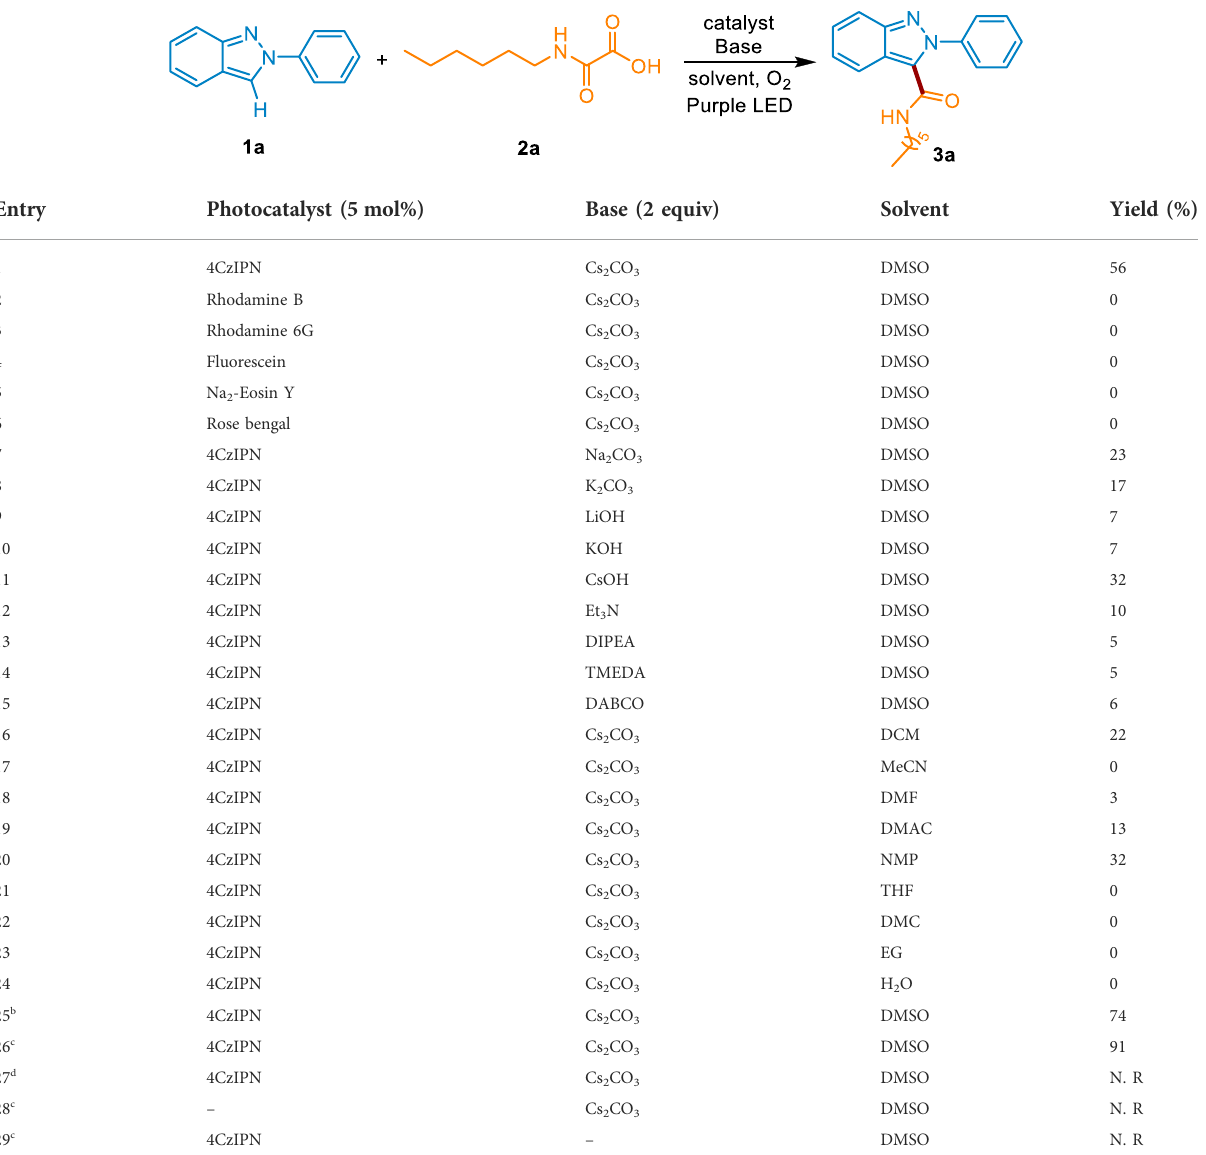
TABLE 1 Optimization of reaction conditions a .